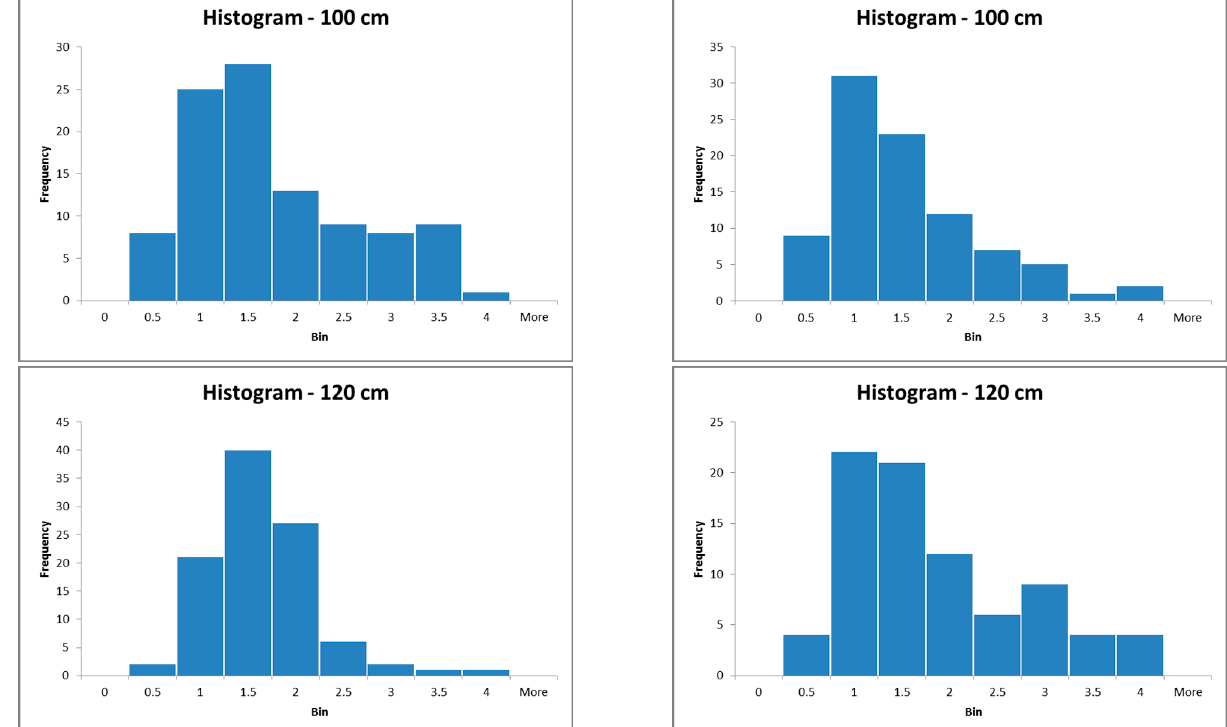
Figure 15. Distributions of roughness computed for each combination configuration, the left pane shows the Hisgotrem— 58 cm/ 65 cm/ 100 cm/ 120 cm of Flood Lighting; the rightt pane shows the Hisgotrem—58 cm/ 65 cm/ 100 cm/ 120 cm of.Spot Lighting.